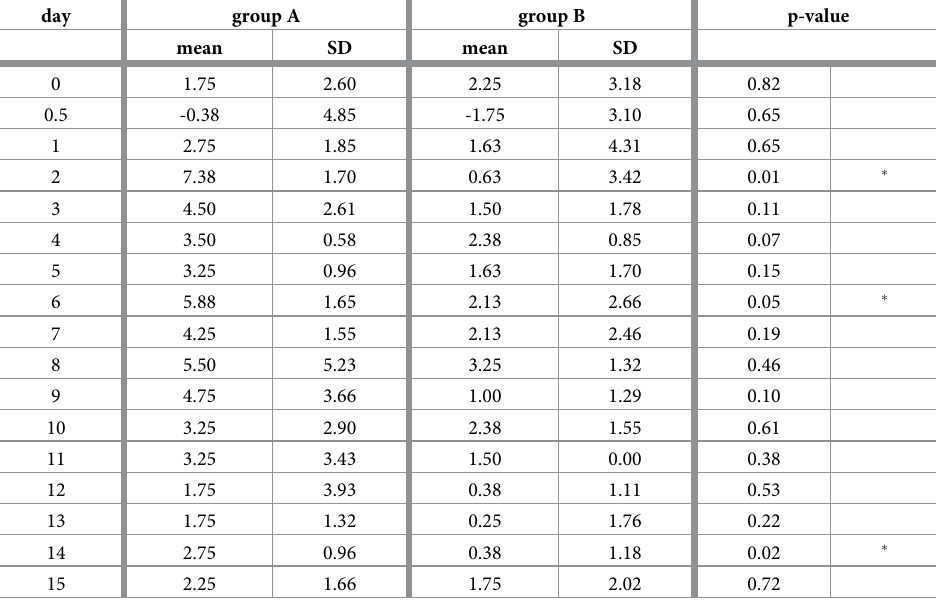
Table 1. Mean IOP differences between the operated and control eye within groups A and